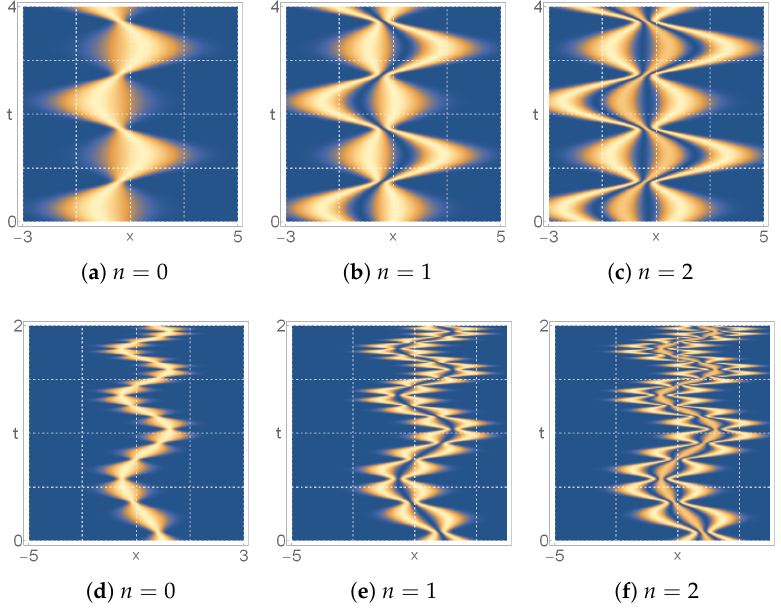
Figure 4. Probability distribution in the bi-product sense (49) for the constant mass case Γ = 0 (first row) and the time-dependent mass case Γ = 1 (second row). The parameters are the same as in Figure